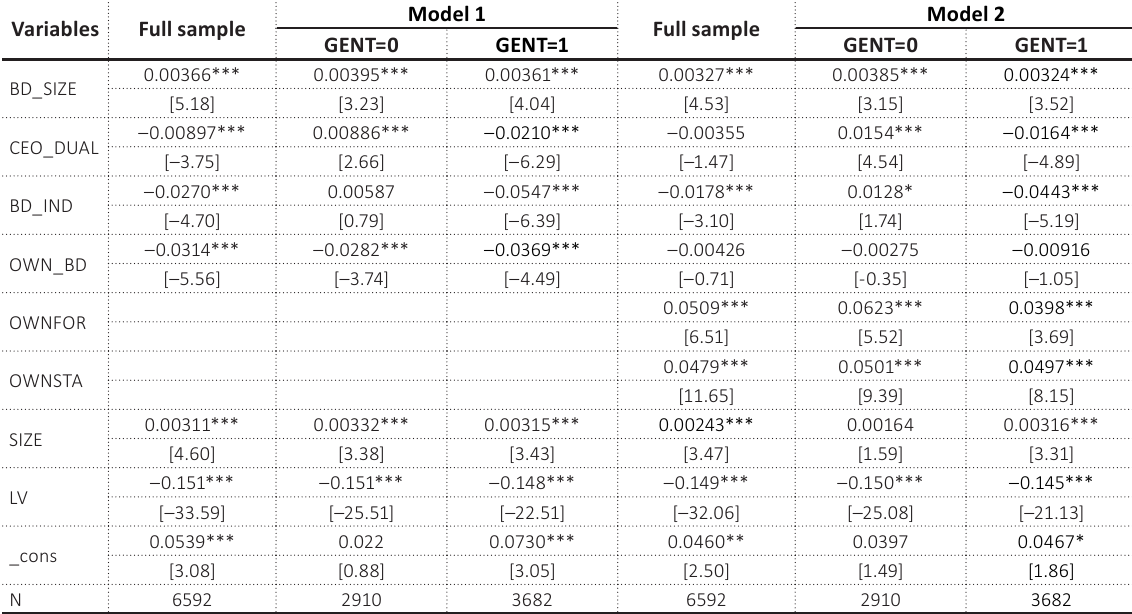
Table 5. Regression results considering the role of female members in the BOD